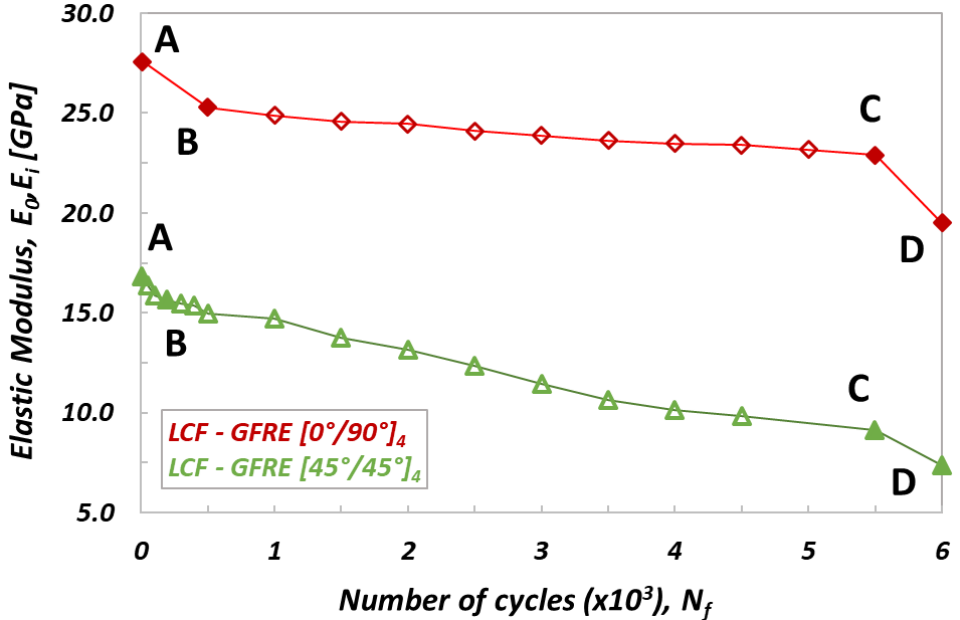
Figure 5. Variation of the elastic modulus versus number of cycle for specimens of different fibers orientation obtained for LCF tests. AB — crack initiation (crack in the transverse yarn), BC — crack growth (interlaminar debonding), CD — ultimate failure (fibers breakage).